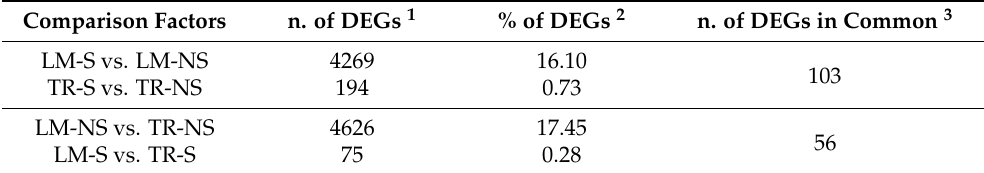
Table 2. The number of differentially expressed genes (DEGs) in sanitized (S) and non-sanitized (NS) artichoke samples of Locale di Mola (LM) and Troianella (TR).